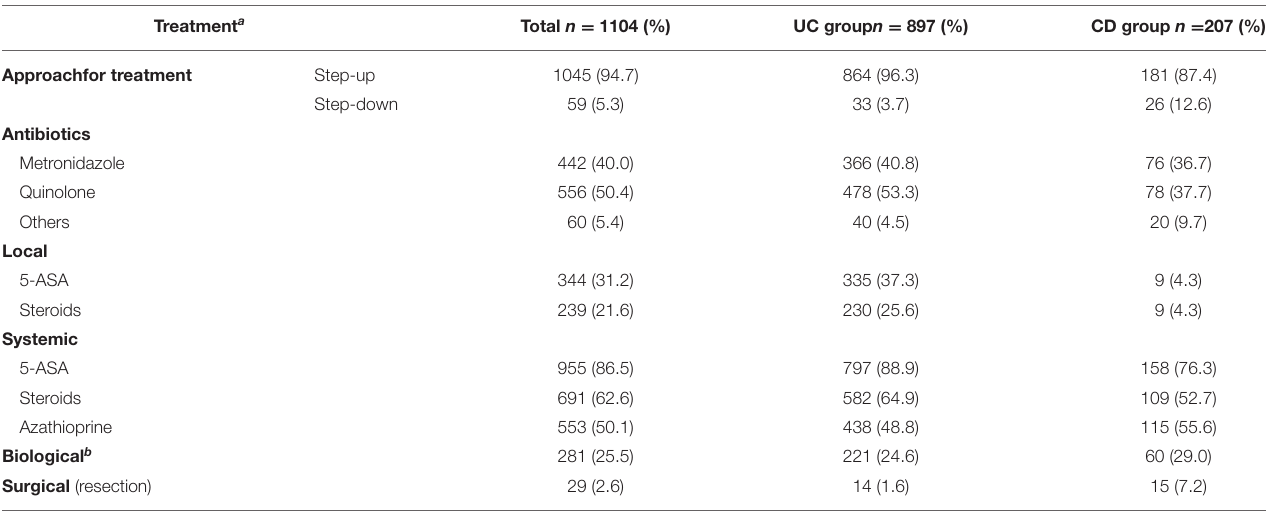
TABLE 4 | Treatment characteristics of patients with inflammatory bowel disease in Egypt (May 2018 to August